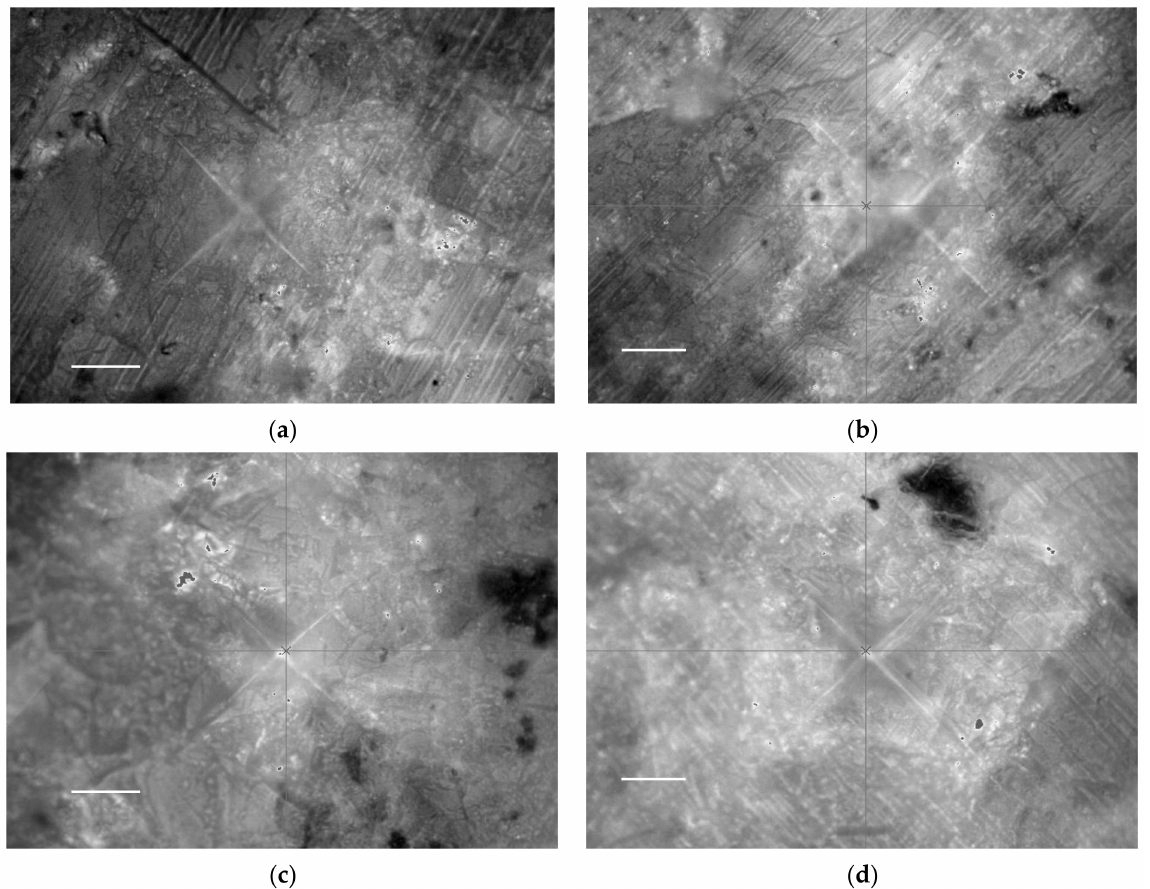
Figure 11. Optical micrographs of Vickers residual indentations of silica gel and MWCNT composites at 300 K: ( a ) SG. CNT silica gel at ( b ) 0.25 wt%, ( c ) 0.5 wt%, and ( d ) 0.75 wt%. Edges of indentation along with diagonal cracks are clearly defined. See scale bar is a 100 µ m. Table 3. Vickers hardness values (Hv), at 200 gf load and 15 s loading time, of various composites of SG/MWCNTs (CN1, CN2, and CN3) with different concentrations of MWCNTs (0.25, 0.50,